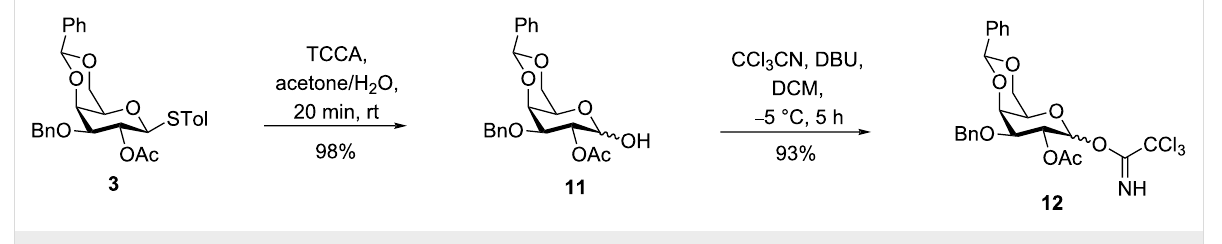
Scheme 4: Synthesis of ᴅ -galactose donor 12 .